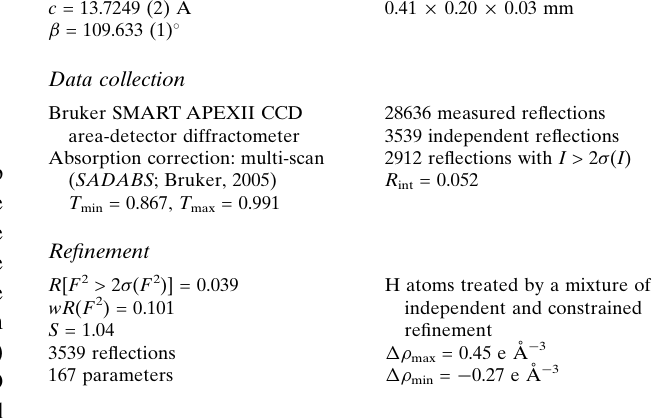
Bruker SMART APEXII CCD area-detector diffractometer Absorption correction: multi-scan ( SADABS ; Bruker, 2005) T min = 0.867, T max = 0.991